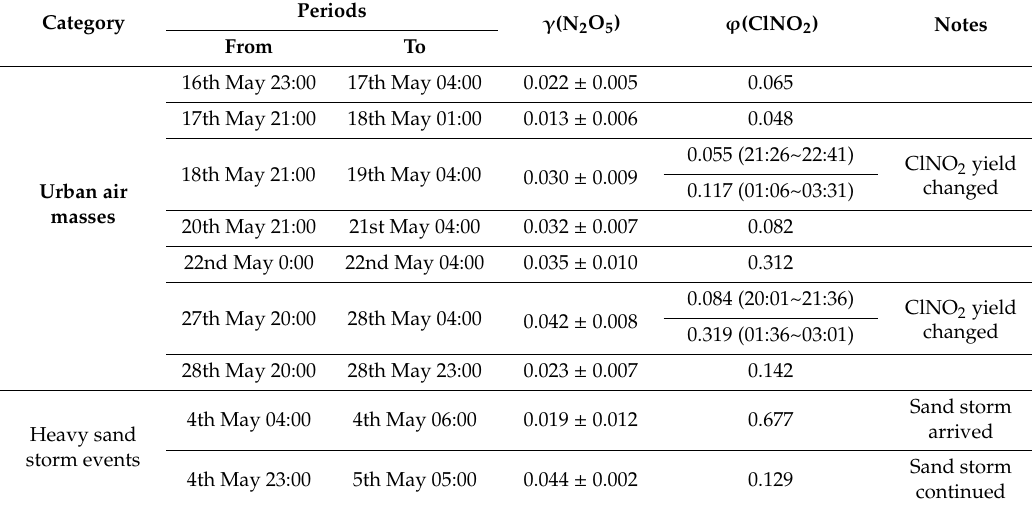
Table 1. Field-derived N 2 O 5 uptake coe ffi cient (average ± standard deviation) and ClNO 2 production yield estimated for the selected periods. The time periods are all local time (LT). Since only one ϕ (ClNO 2 ) value was derived for each time period, no standard deviation was obtained for